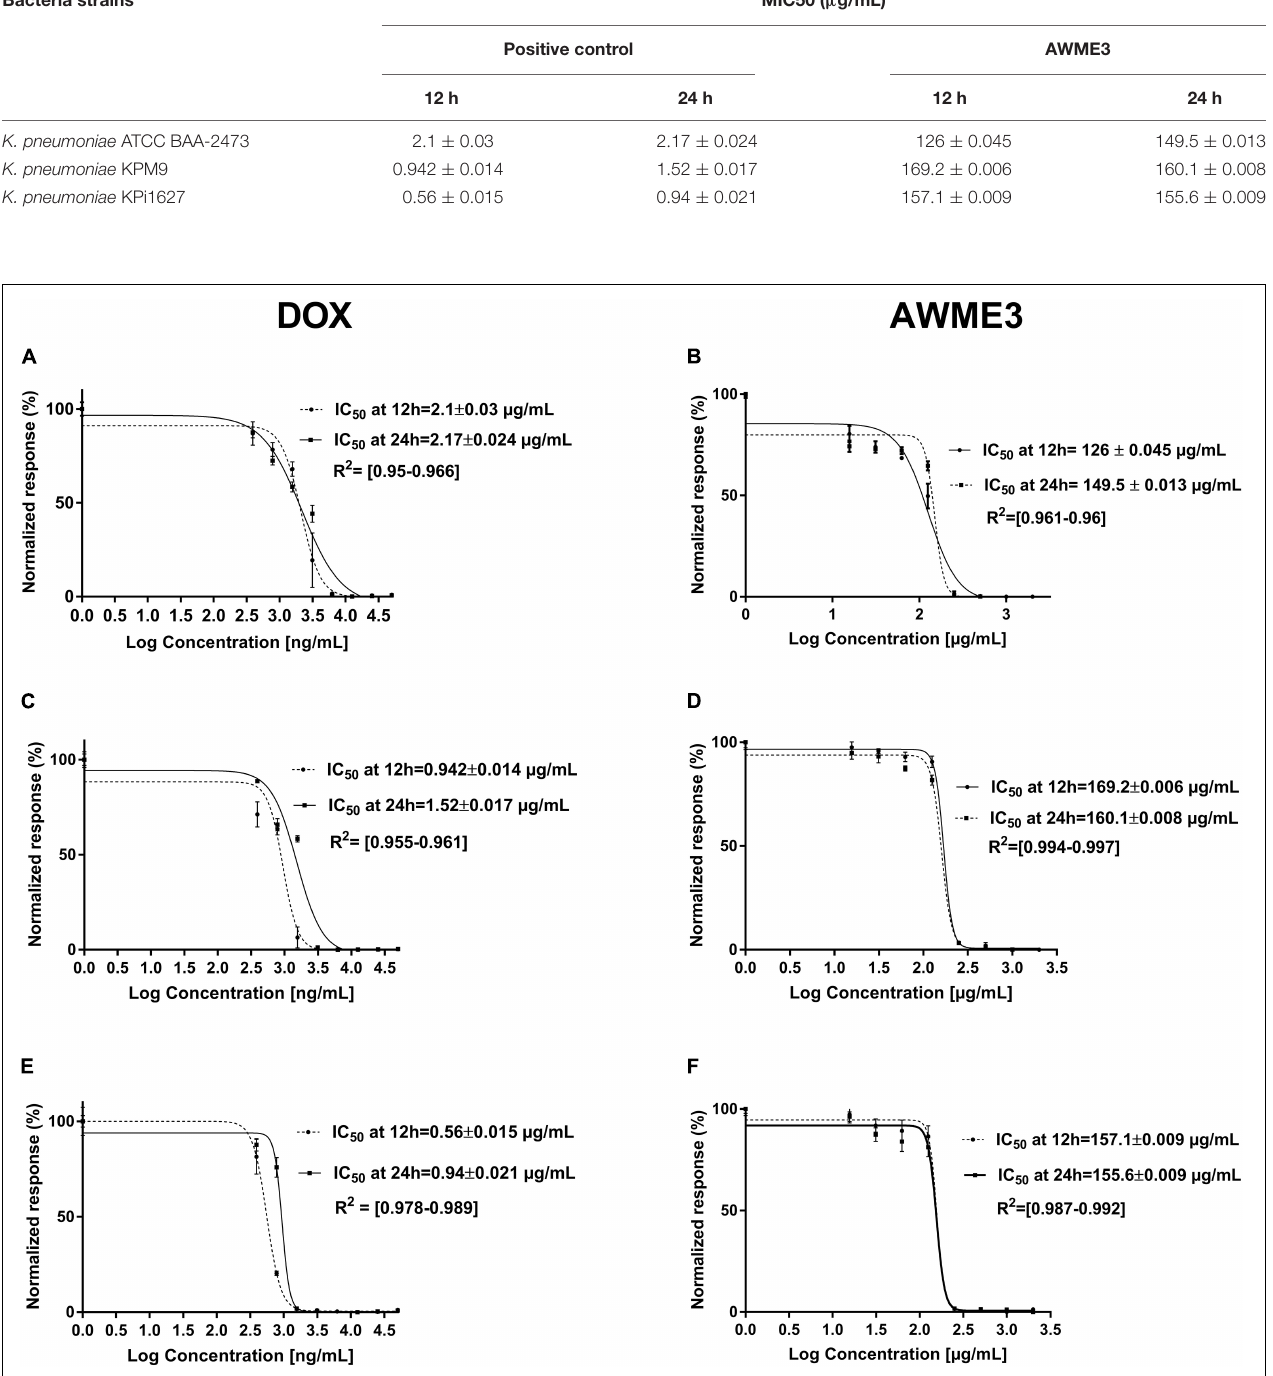
TABLE 4 | Half of the inhibitory concentration (MIC 50 ) values of AWME3 and positive control against MDR K. pneumoniae strains. Bacteria strains